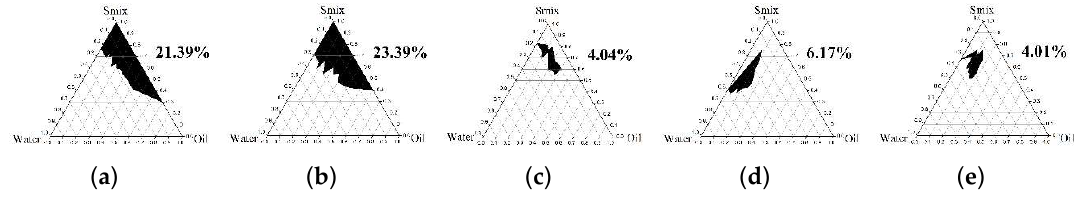
Figure 5 . Pseudoternary phase diagram of CA / Tween 85 and ethanol / water, when the Smix ratio was ( a ) 6:1; ( b ) 4:1; ( c ) 2:1; ( d ) 1:1; ( e ) 1:2. The dark area represents the microemulsion region.